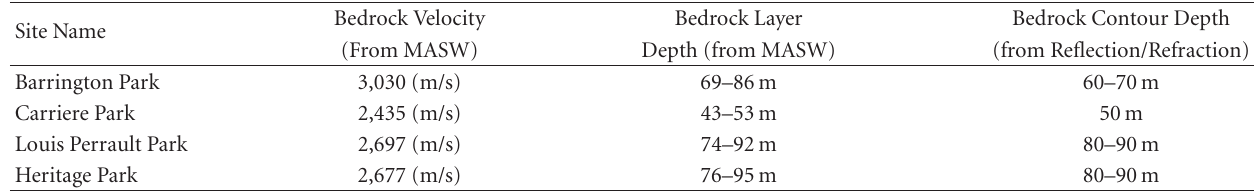
Table 4: Comparison between estimated MASW results and those of the reflection/refraction methods [5] for deeper bedrock in the Orleans